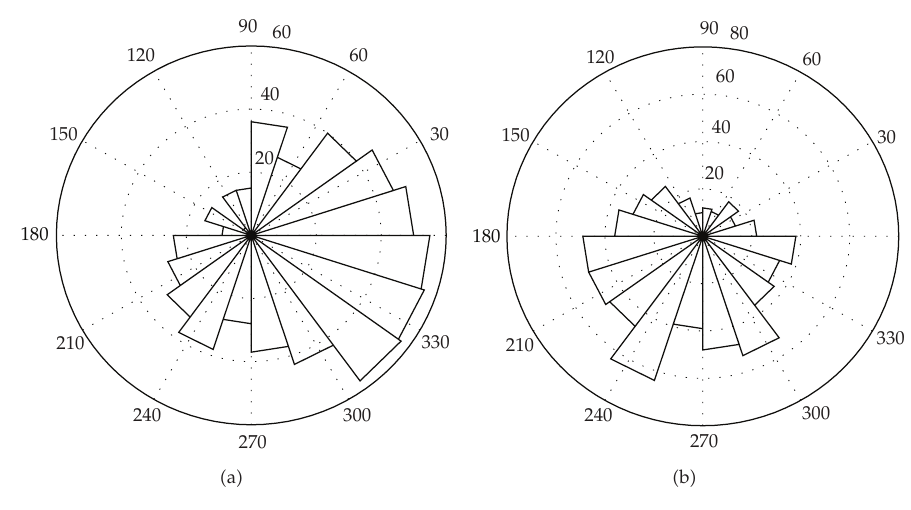
Figure 12: The rose histogram of elements of the absolute di ff erences of the predicted and original data using ARMA (cid:2) a (cid:3) and DWT-ARMA (cid:2) b (cid:3) for single channel (cid:2) ch-2 (cid:3) .